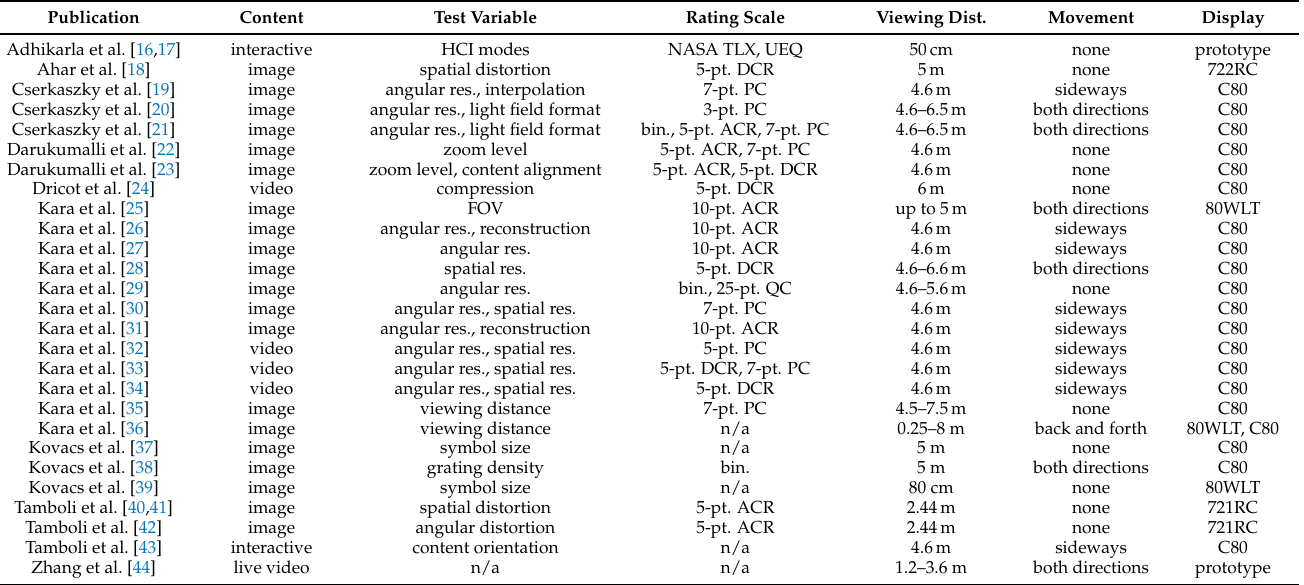
Table 1. Summary of the related